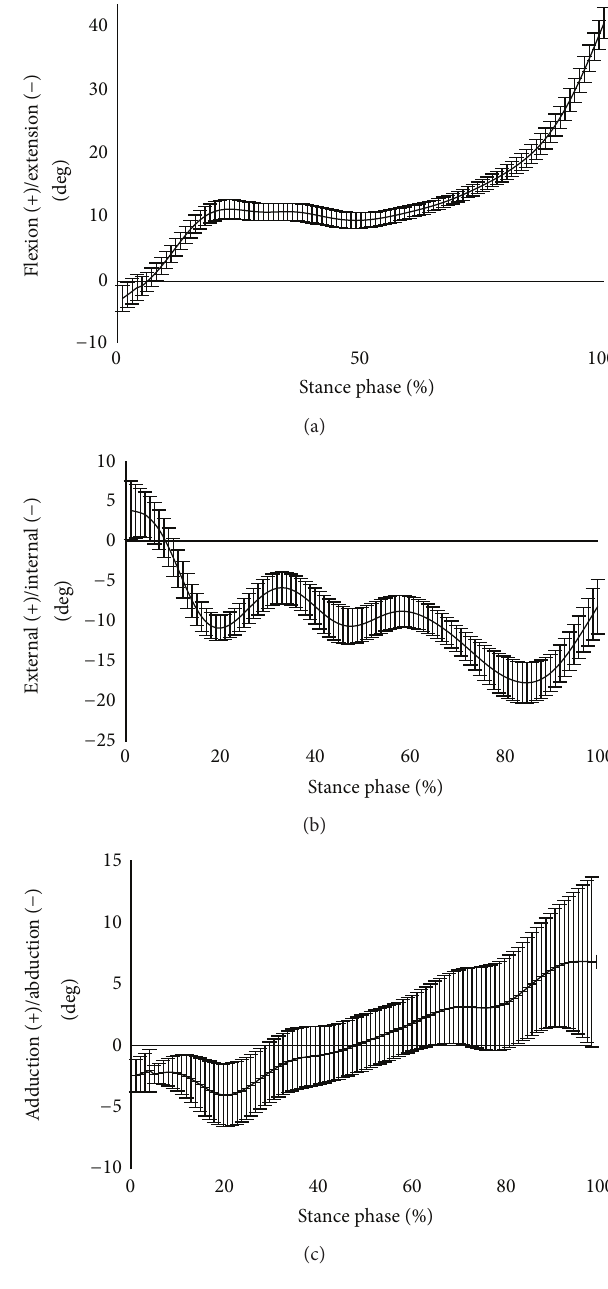
Figure 4: Representative data for the joint angle of Subject 3: (a) flexion-extension; (b) external-internal rotation; (c) abduction- adduction. The vertical bars show the